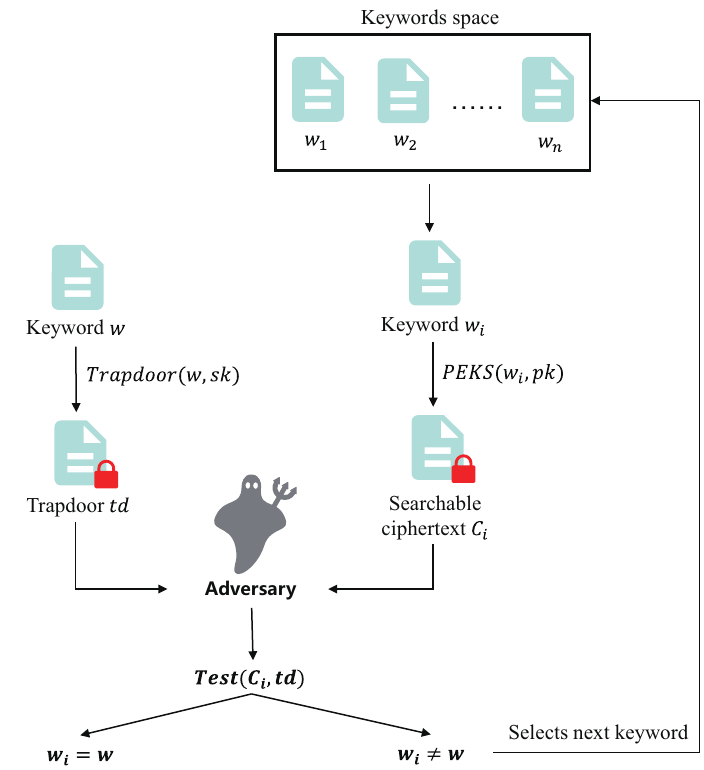
Figure 2. Keyword guessing